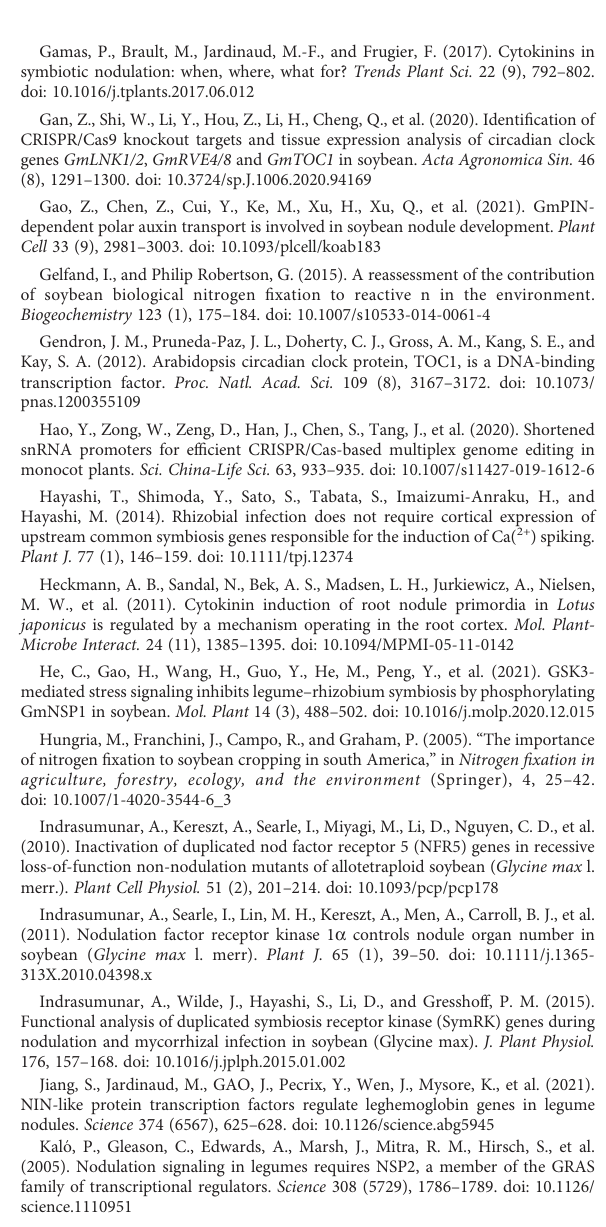
Content of leghemoglobin in nodules from W82 and Gmtoc1b mutants. Data are means ± SD of three independent samples. Lowercase letters indicate signi fi cant differences as determined by Student ’ s t